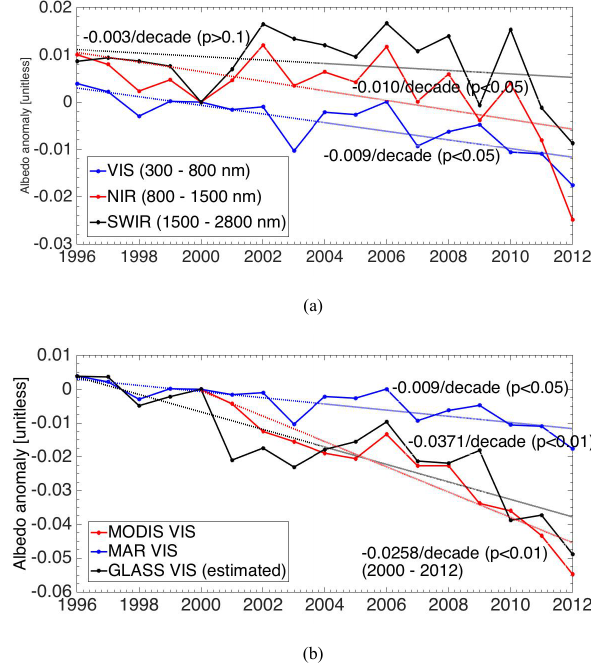
Figure 5 Figure 5. Time series of modelled and measured mean sum- mer (JJA) albedo anomalies (with respect to the year 2000) in different spectral bands. (a) Visible, near-infrared, and shortwave- infrared albedo values simulated by MAR; (b) as in (a) but for the visible albedo only from MAR, MODIS (obtained from the prod- uct MCD43), and GLASS. Note that the vertical axis scale in (b) is different from that in (a)